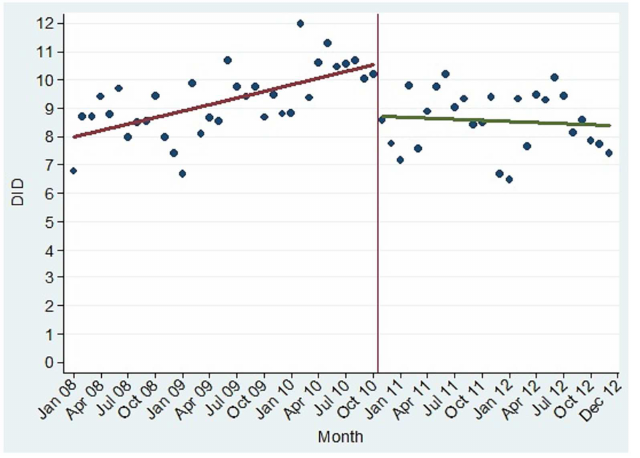
Fig 1. Monthly oral antibiotic consumption in the state of S ã o Paulo. * DID: defineddaily doses per 1,000 inhabitants per day. The vertical line represents the issuingof the law.